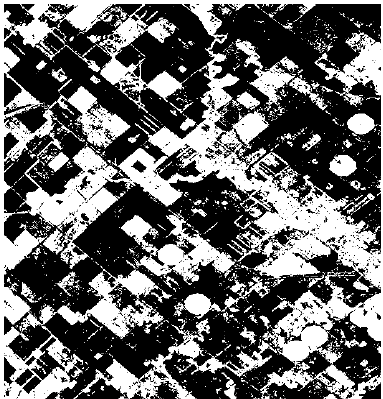
Figure 6. Resulted change map by proposed method. Black colour described as change and white show un-changed classes. Difference of entropy and anisotropy in the temporal dataset is the reason of large amount of detected changes. For identification of detected changes using auxiliary data such as soil moisture and vegetation height can be very interesting. For the quantitative validation of presented approach, 216 pixels are used to evaluate the confusion matrices, kappa coefficient and overall accuracy. These data have been uniformly selected from the change and no-change classes. Also the results are compared with the detected changes by classic c- means clustering algorithm in the term of quantitative parameters. Table 1 shows quantitative comparison between the results of our approach and the c-means clustering method and also single channel images for change detection paradigm.